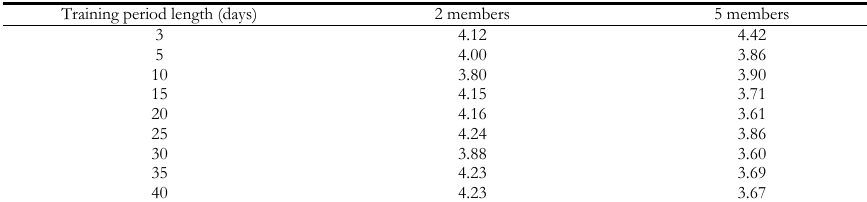
RMSE for BMA (test day: May 1 st